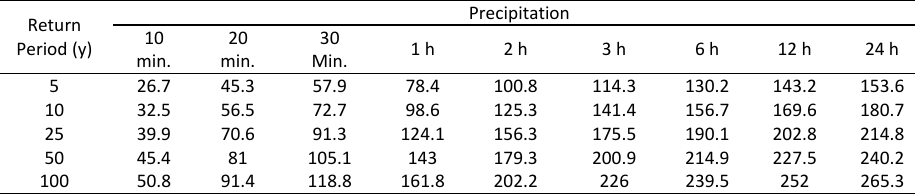
Fig. 3: RIDF curve of Malaybalay City Synoptic Rainfall station Table 3: Computed extreme values of precipitation (mm)